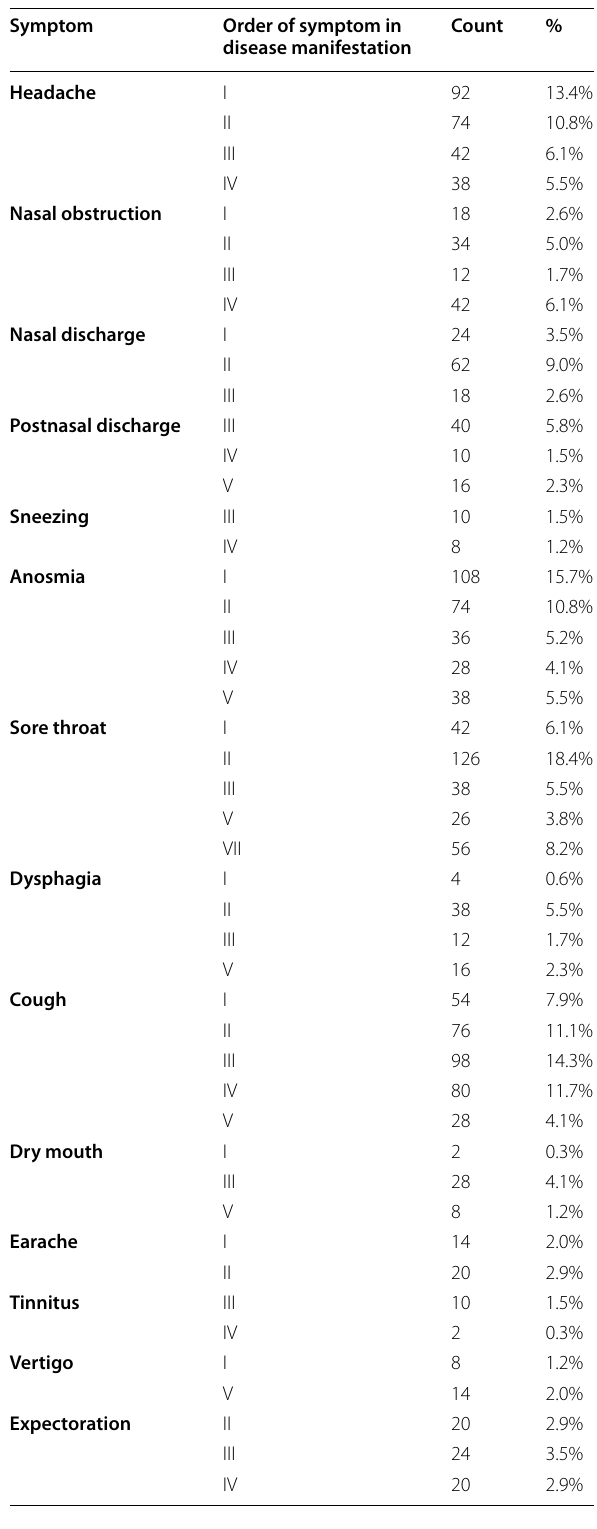
Table 3 Chronological order of ORL symptoms in COVID-19 patients